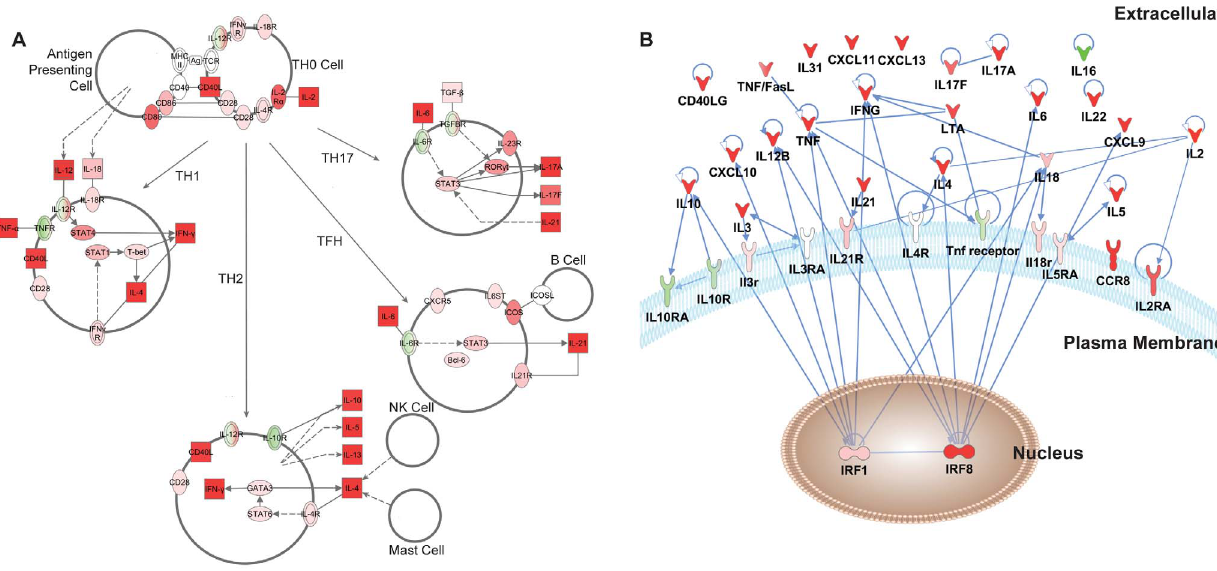
Figure 5. Network interactions of differentially regulated genes in DN T cells. A) An unsupervised in silico model of genes upregulated in DN T-cells upon TCR stimulation identifies cytokines characteristic of T-helper differentiation (Th1, Th2, T FH and Th17 subtypes) with upregulated (red) and downregulated (green) gene expression depicted. The model also depicts how cytokines expressed by DN T cells may influence immune cells such as antigen presenting cells, B cells, NK cells and mast cells. Squares represent secreted proteins whereas ovals depict receptors or regulatory proteins. B) A network of interactions between the most highly regulated cytokines and their respective regulatory proteins from TCR stimulated DN T cells. Nodes (gene names) represent the upregulated (red) and downregulated (green) cytokines. Edges (blue lines) represent direct interactions between the cognate proteins. The compartmentalization of these proteins into extracellular expression, plasma membrane surface expression and nuclear expression is also depicted. doi:10.1371/journal.ppat.1003441.g005 interacting protein 3) an anti-inflammatory gene that limits NF- k B signaling and signaling molecule RGS4 (also a negative